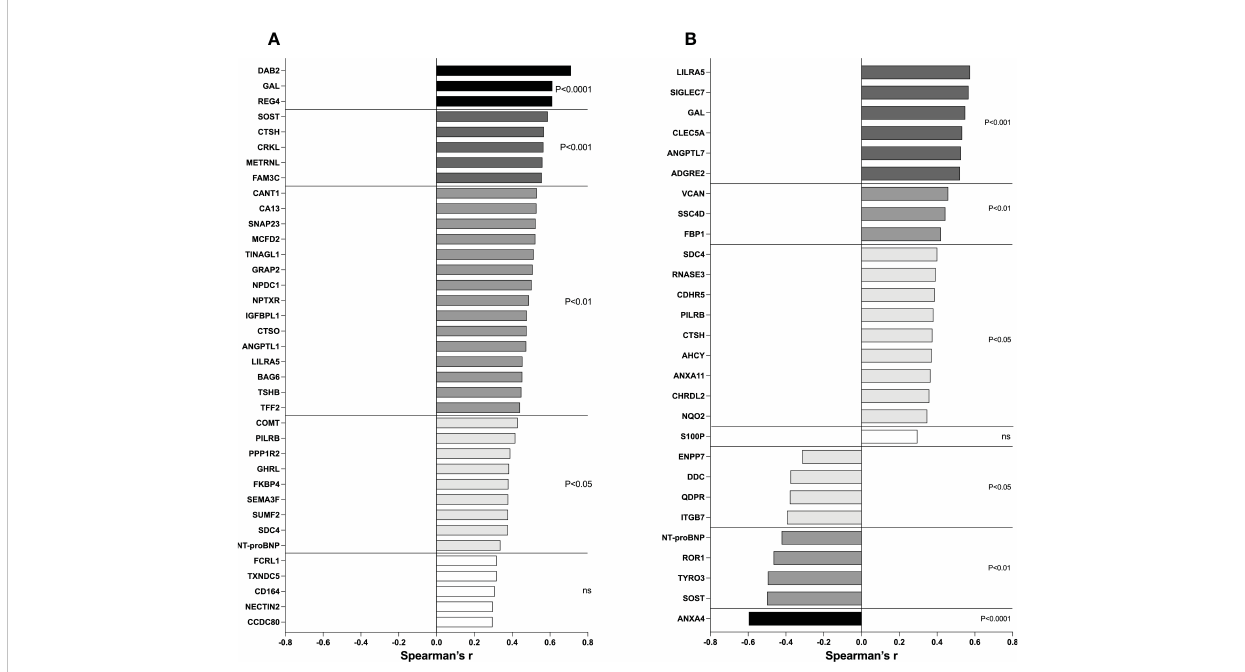
FIGURE 7 Correlations between metabolic proteins and LTF and estradiol. (A) Postmenopausal women underwent MRI and microdialysis for collection of proteins from the extracellular space as described in the Materials and Methods. Correlation analysis between proteins and breast density (LTF) was performed. (B) Postmenopausal women with dense breast tissue and premenopausal women underwent microdialysis as described in the Materials and Methods. Correlation analysis between proteins and local breast estradiol was performed. Bars represent Spearman ’ s rank correlation coef fi cients. Colored bars indicate statistical signi fi cance, and white bars indicate ns=not signi fi